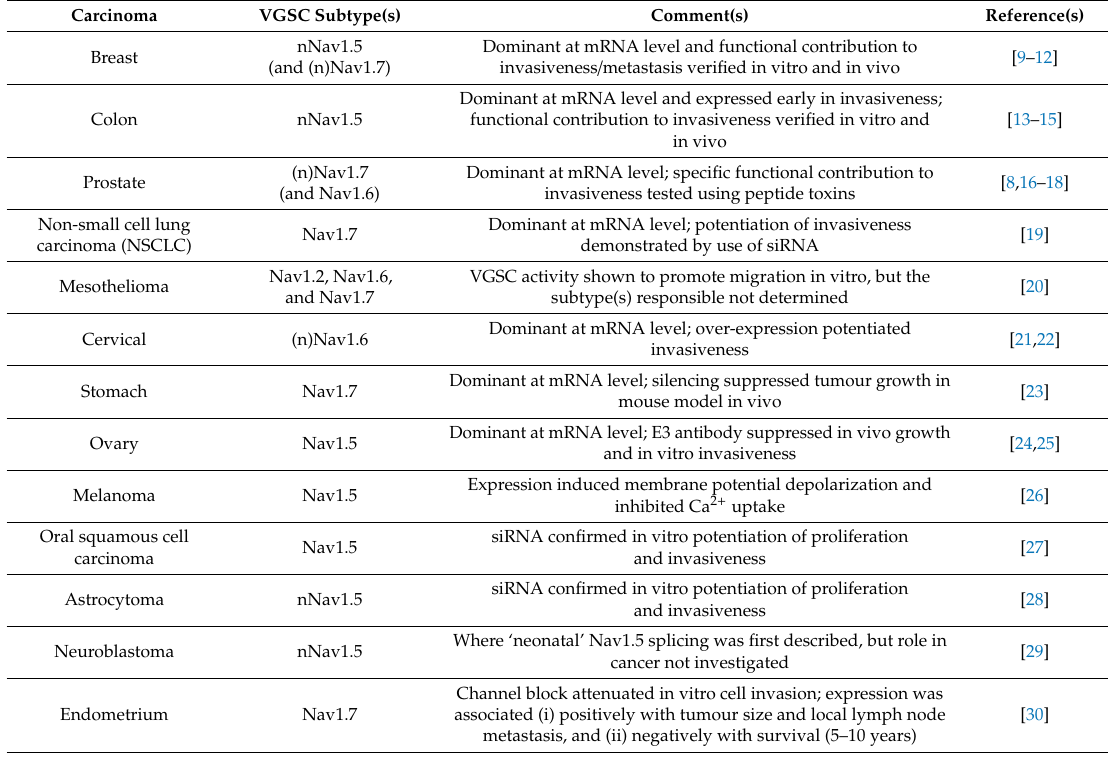
Table 1. Voltage-gated sodium channel (VGSC) subtype expression in human carcinomas.